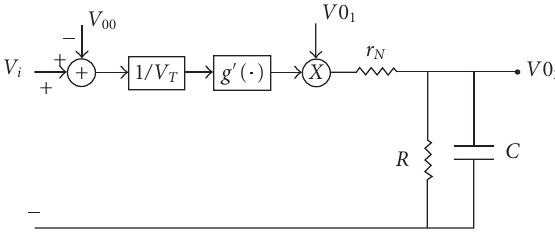
Figure 3.5. Second-order perturbation model for diode in half-wave